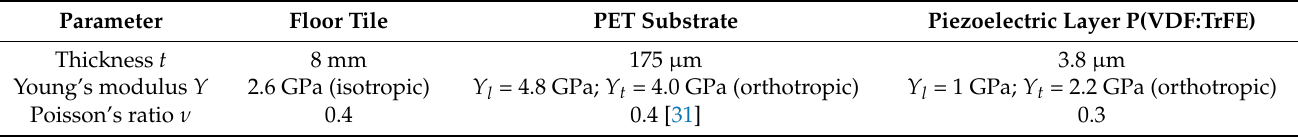
Table 1. Mechanical material parameters of the layers. Poisson’s ratios were taken either from literature (for PET) or estimated based on FEM simulations. The Young’s moduli were obtained by tensile tests (PET), three-point flexural test (for the floor tile) or from previous works (piezoelectric layer based on